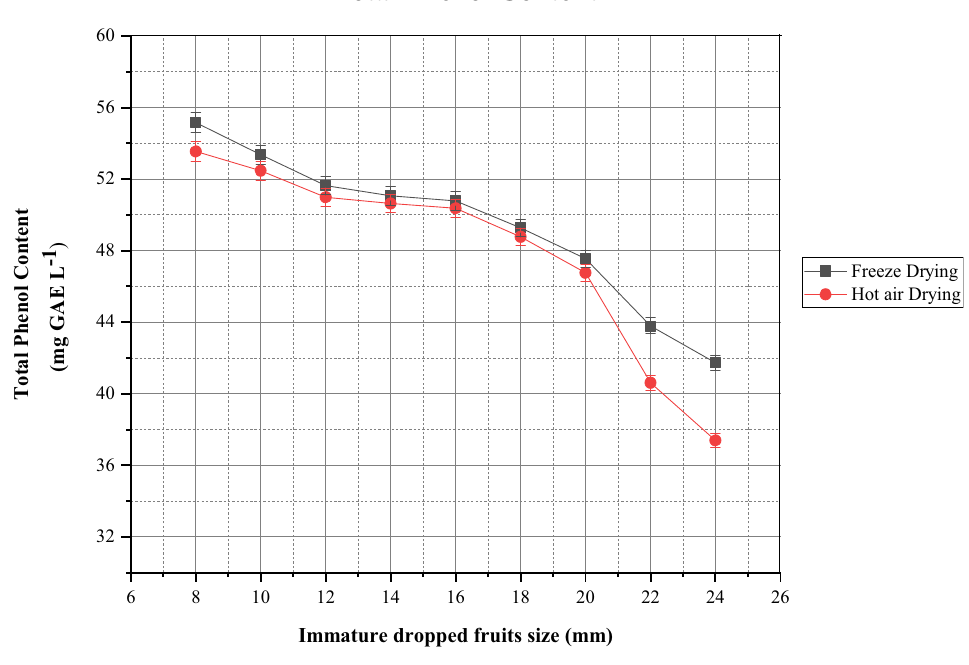
Figure 6. Content of total phenol (TPC) after freeze drying and hot air oven drying in different sizes of immature C. sinensis L. Osbeck dropped